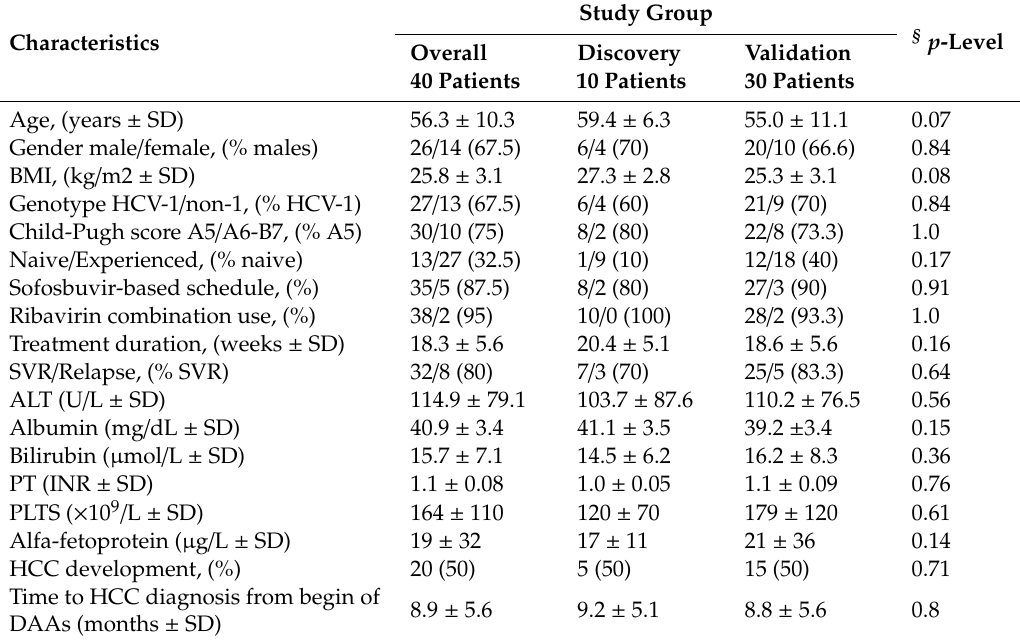
Table 1. Characteristics of cirrhotic patients enrolled in the study groups.